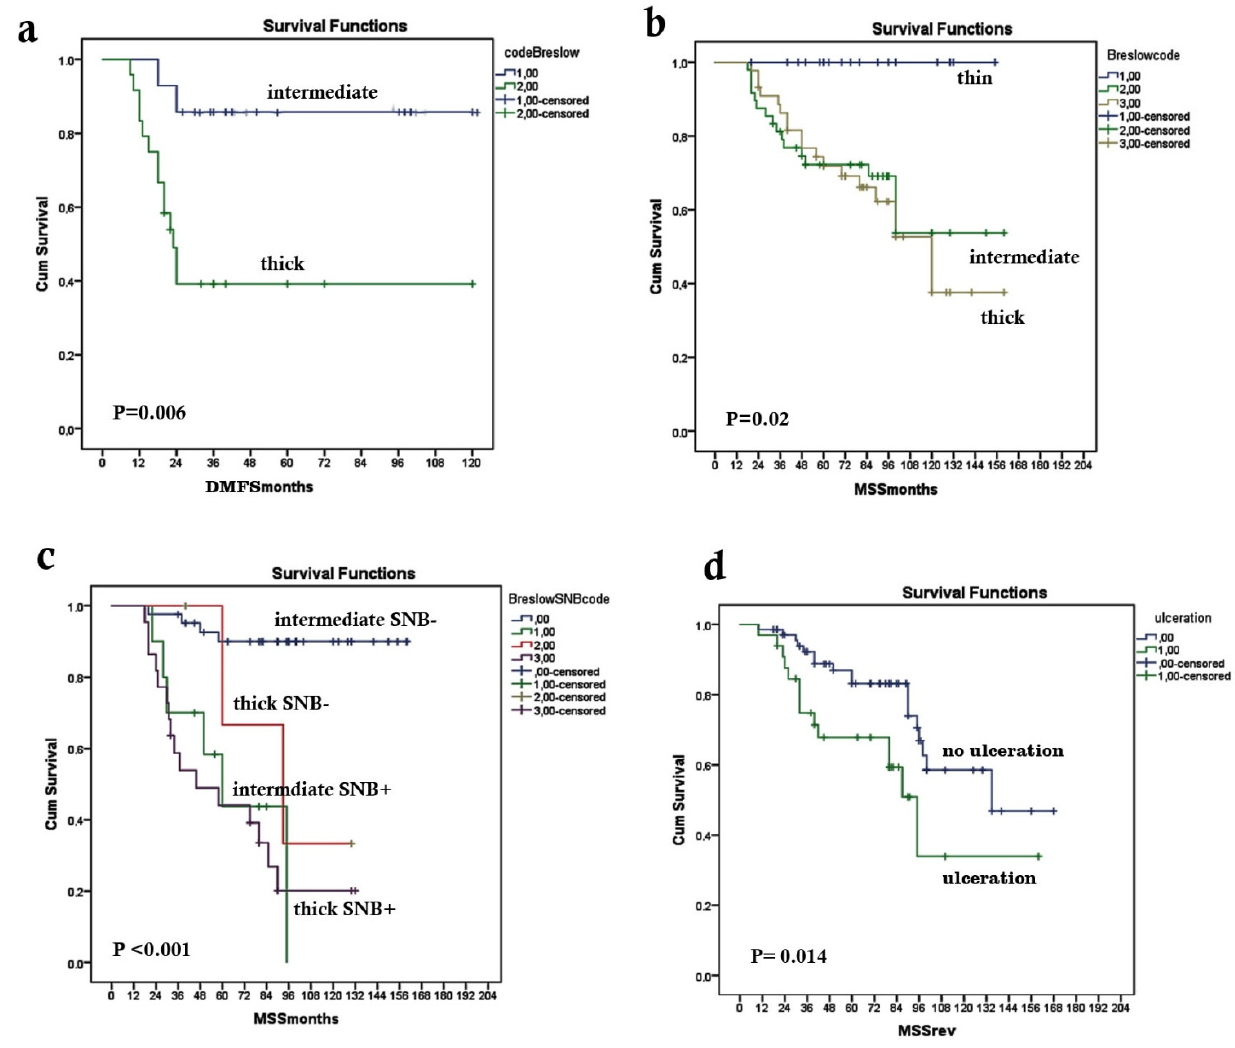
Figure 1. Kaplan–Meier analysis of Distant Metastasis Free Survival (DMFS) and Melanoma Specific Survival (MSS). ( a ) Patients with thick melanomas were significantly associated with shorter DMFS respect to the patients with intermediate melanoma. ( b ) Breslow thickness was significantly associated with MSS. ( c ) Breslow thickness >1 mm (intermediate and thick melanoma) associated with positive sentinel node biopsy (SNB) and ( d ) tumor ulceration presence were significant negative prognostic factors for MSS.